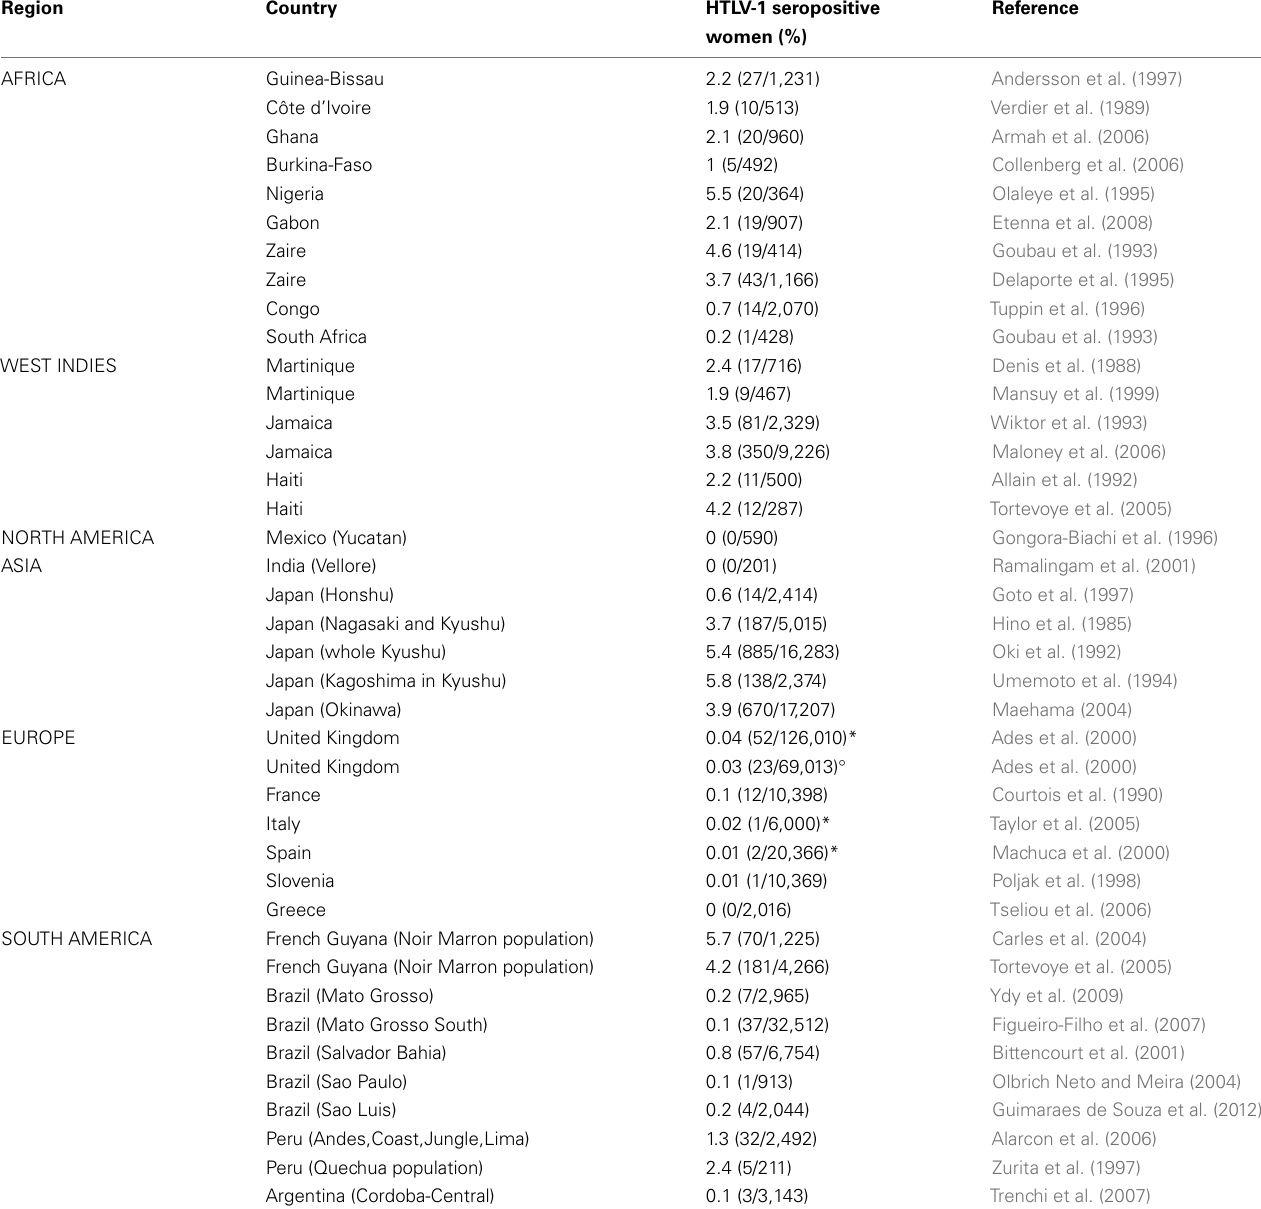
Table 1 | HTLV-1 seroprevalence among pregnant women originating from HTLV-1 endemic countries inAfrica,West Indies, North and South America,Asia, and